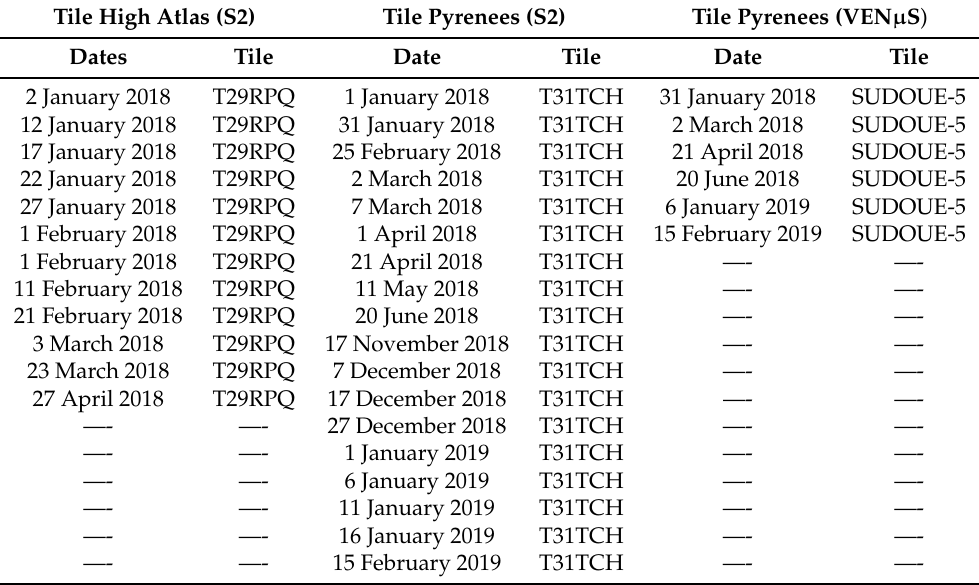
Table 2. Date of acquisition of Sentinel-2 images for the two sites (T29RPQ and T31TCH) and (VEN µ